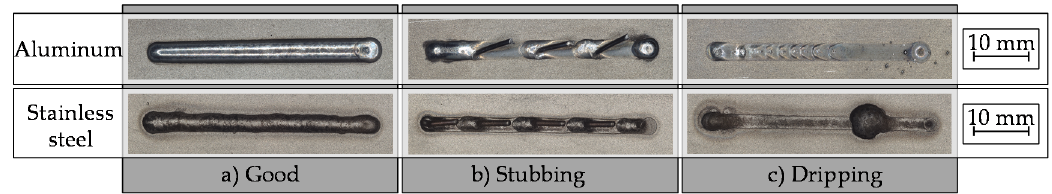
Figure 5. Categories for the classification using aluminum examples on the upper row and stainless steel examples on the bottom row: ( a ) good, ( b ) stubbing, and ( c ) dripping.